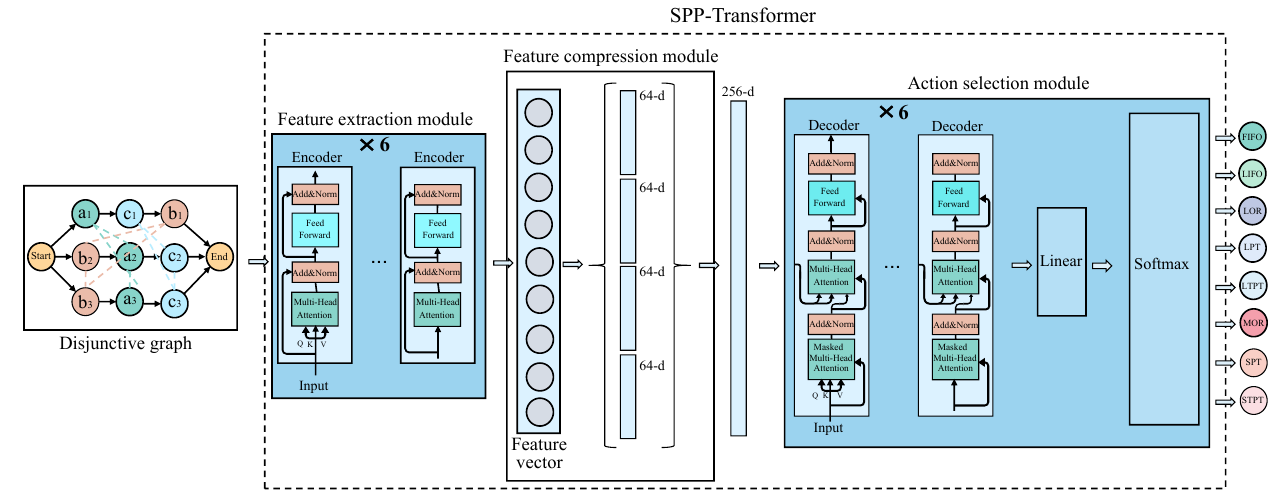
Figure 3. The whole framework of